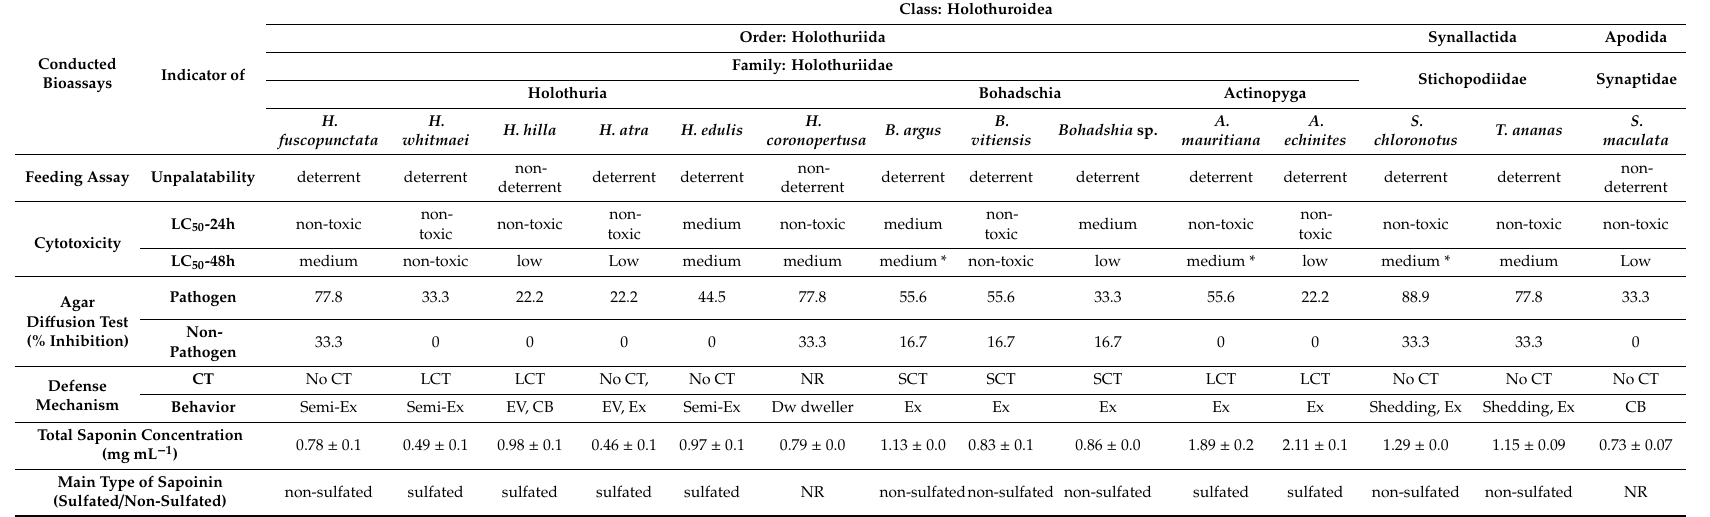
Table 1. Summary of all biological activities tested against the 14 sea cucumber crude extracts (cf. Figure 7 and Figure